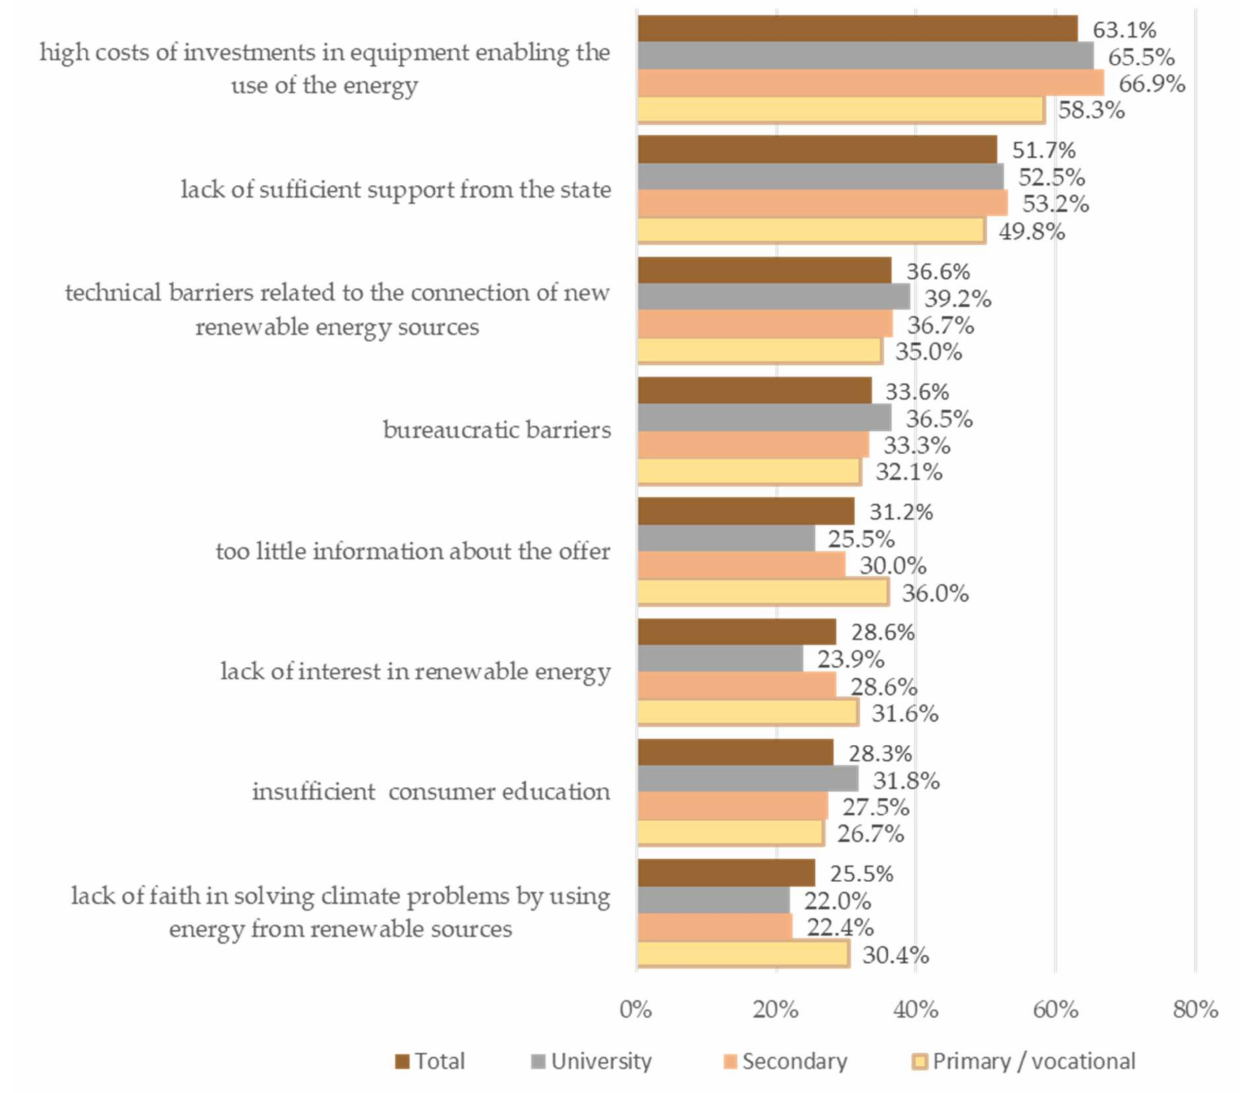
Figure 1. The importance of the factors limiting the increase in the scope of the use of renewable energy sources in Poland. Source: Author’s own